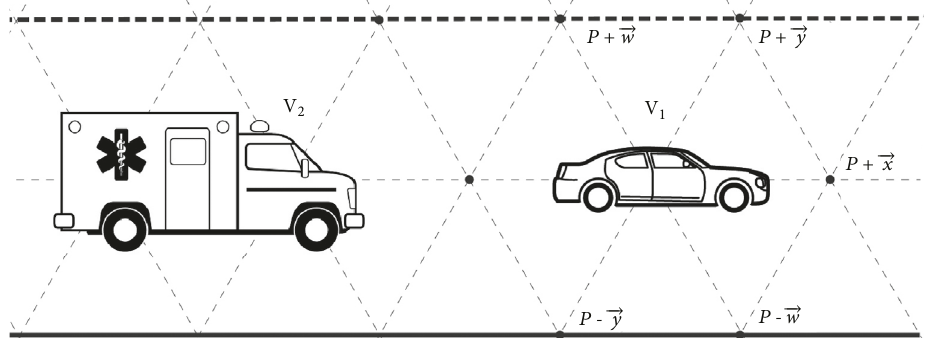
Figure 2: The grid system. 𝑉 1 shows a standard vehicle located in a single site 𝑃 and 𝑉 2 shows a longer vehicle, an ambulance, modeled by using two adjacent